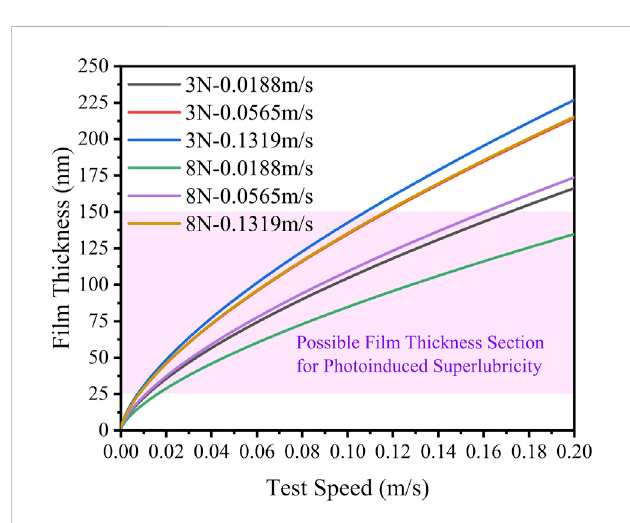
FIGURE 6 Film thickness calculated by the H-D formula in 70% glycerol solution under different running-in conditions. The purple section is possible because of the fi lm thickness section for photoinduced superlubricity because of the lubrication